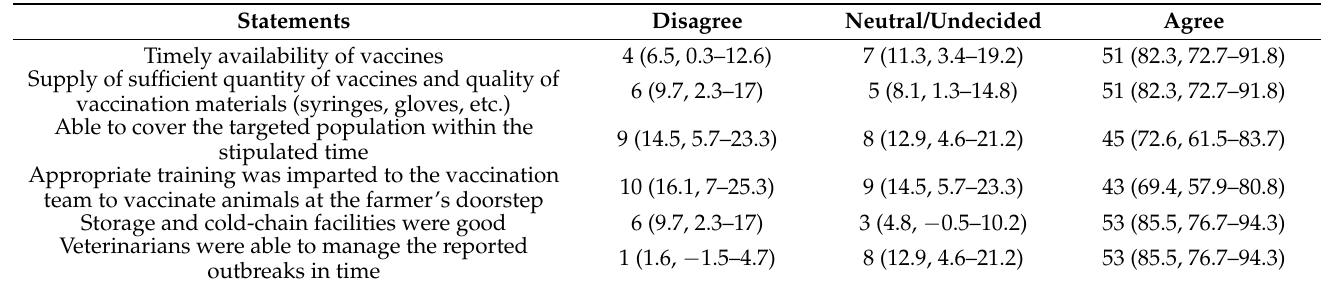
Table 5. Perceptions of veterinarians regarding the performance of the functional components of PPR-CP in Karnataka ( n =